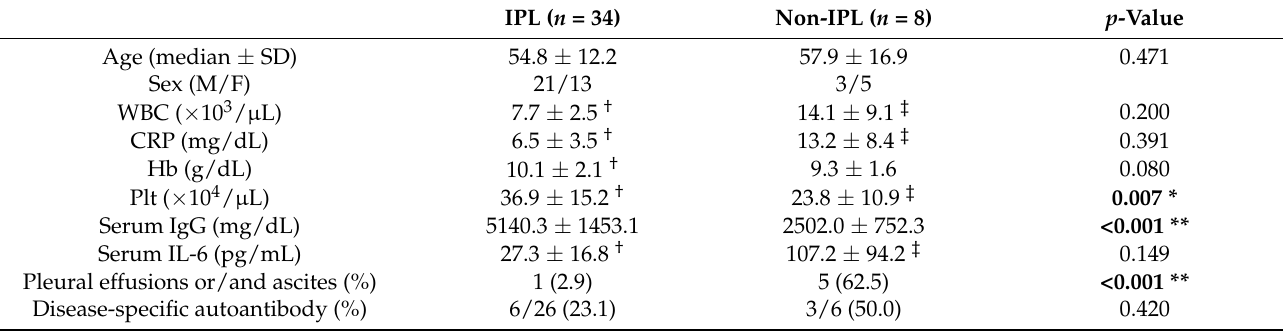
Table 1. Clinicopathological findings of